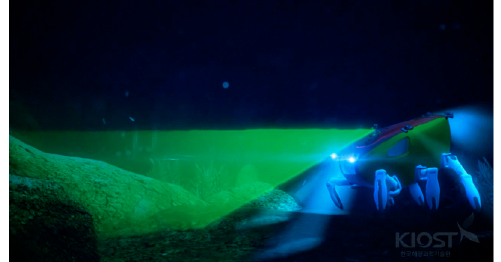
Figure 10. Tilt angle adjustment to the sector-scanning sonar concept for the CR200 [25].